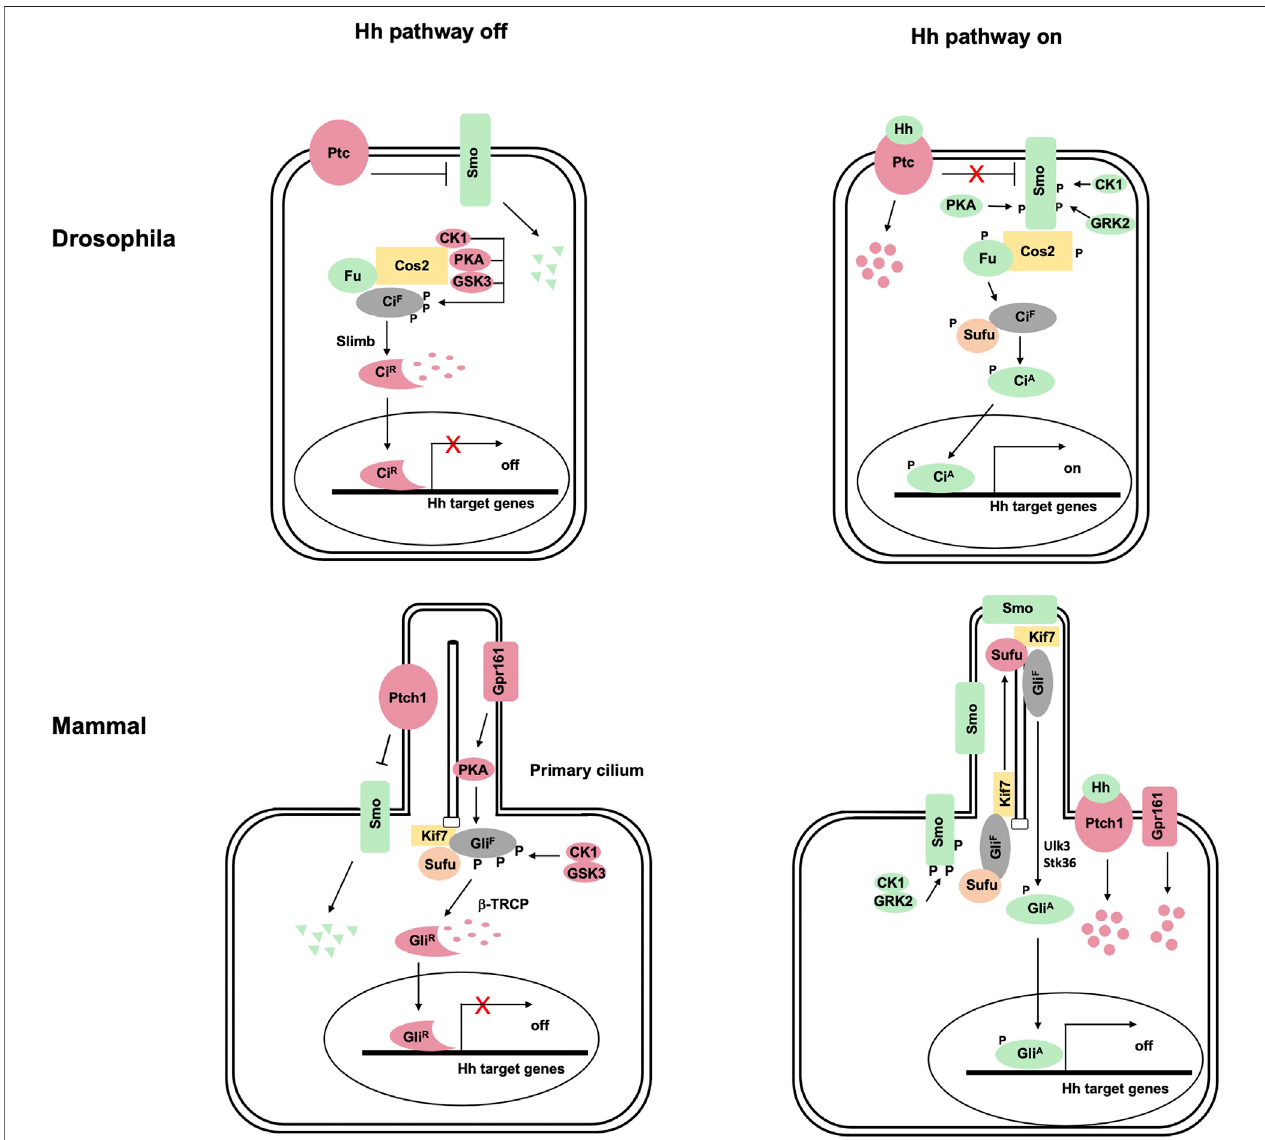
FIGURE 1 | The hedgehog signaling transduction in Drosophila and vertebrates. (A) In Drosophila , the 12-span transmembrane protein Ptc represses the GPCR- familyprotein SmointheabsenceofHh ligand,leadingtothedegradation ofSmobytheubiquitylationpathway. Full-length Ci(Ci F )forms acomplexwiththekinesin-like protein Cos2 and the Ser/Thr kinase Fu, which recruits PKA, GSK3, and CK1 to phosphorylate Ci. Phosphorylation of Ci F targets it for Slimb-mediated ubiquitination, followedbyproteasome-mediatedproteolysistogenerateCi R .BindingofHhtoPtcreleasesitsinhibitionofSmo,allowingSmotobephosphorylatedbyPKA,CK1 and GRK2. Activated Smo not only blocks Ci F phosphorylation by PKA/GSK3/CK1 and thus the production of Ci R but also converts Ci F into the activator form (Ci A ) through activating the Fu kinase, which directly phosphorylates Ci F to release its inhibition by Sufu. (B) Vertebrate Hh signal transduction depends on primary cilia. In the absence ofHh, both Ptch1 and Gpr161 (a GPCR coupled to G ⍺ s) are localized in primary cilia where Ptch1 prevents Smo ciliary localization and Gpr161 activates PKA. Full-length Gli (Gli F ; mainly Gli3 and Gli2) is phosphorylated by PKA, GSK3, and CK1, which targets it for β -TRCP-mediated ubiquitination, followed by proteasome- mediated proteolysisto generate Gli R . Binding ofHh to Ptch1 inhibits its activity and promotes its ciliary exit, allowing Smo to be phosphorylated by CK1 and GRK2 and accumulated in primary cilia. Activated Smo inhibits Ci phosphorylation by PKA and the production of Gli R in part by promoting Gpr161 ciliary exit. In addition, activated Smo converts Gli F into Gli A at least in part through Ulk3 and STK36, which phosphorylate Gli F to attenuate the inhibition by Sufu.